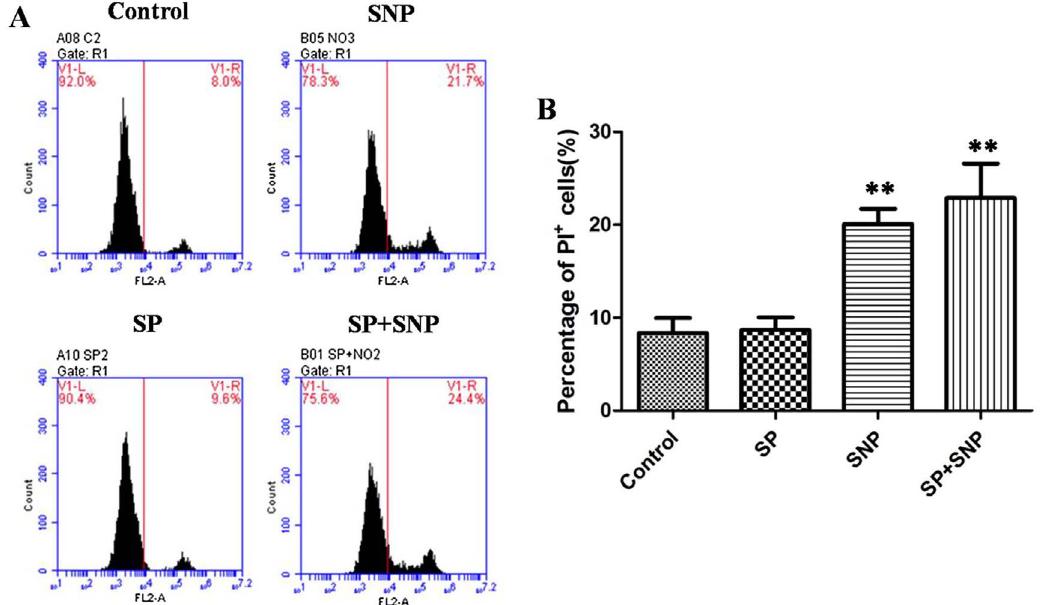
Figure 5. NO-induced egress results in no host cell damage . (A) and (B) Propidium iodide (PI) staining of PCKs in fl ow cytometry, representing percentages of PI + cells after parasite invasion, SNP treatment, or SNP induced egress, no treatment as control. Representative data from one and three independent experiments are shown. Bars indicate means ± SEM ( n = 5). ** p < 0.01.